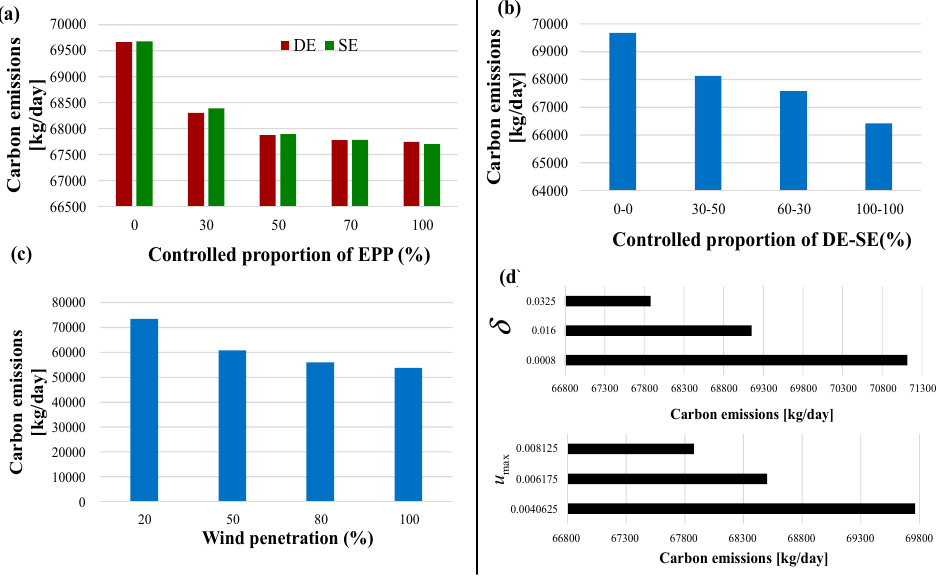
Figure 16. Carbon emissions for ( a ) Case-2, scenarios A and B; ( b ) Case-2, scenario C; ( c ) Case-3; and ( d )